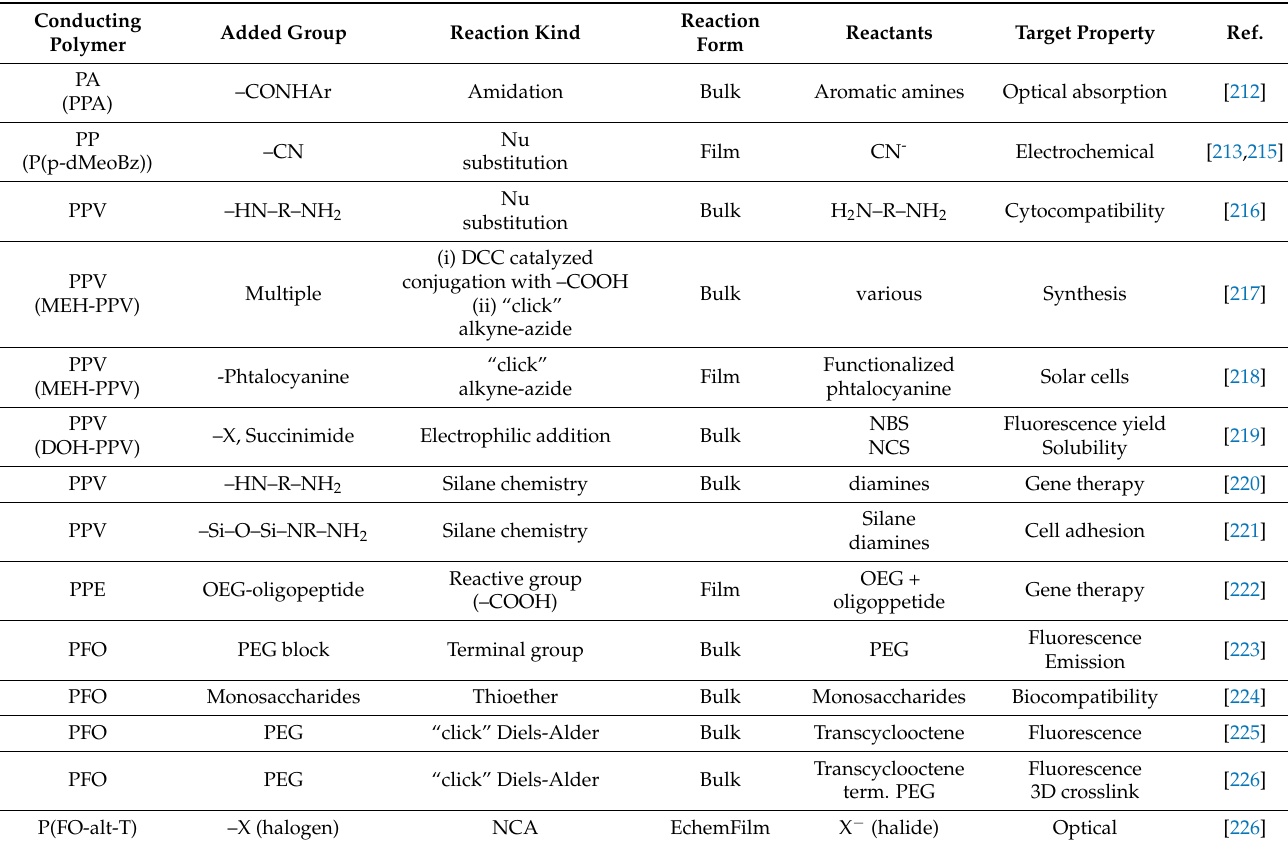
Table 4. Summary of reaction used in the postfunctionalization of other conducting polymers. Reactants Target